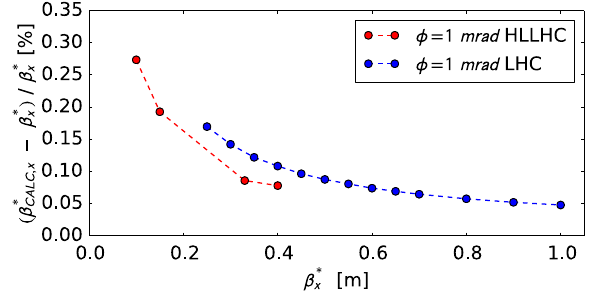
FIG. 10. Deviations of calculated β (cid:1) for the different optics of the LHC and HL-LHC, independently showing the effect of linear coupling with C − ¼ 5 × 10 − 4 and a quadrupole tilt of 1 mrad. Though the effect is small for both, a quadratic increase of the deviations for decreasing β (cid:1) is